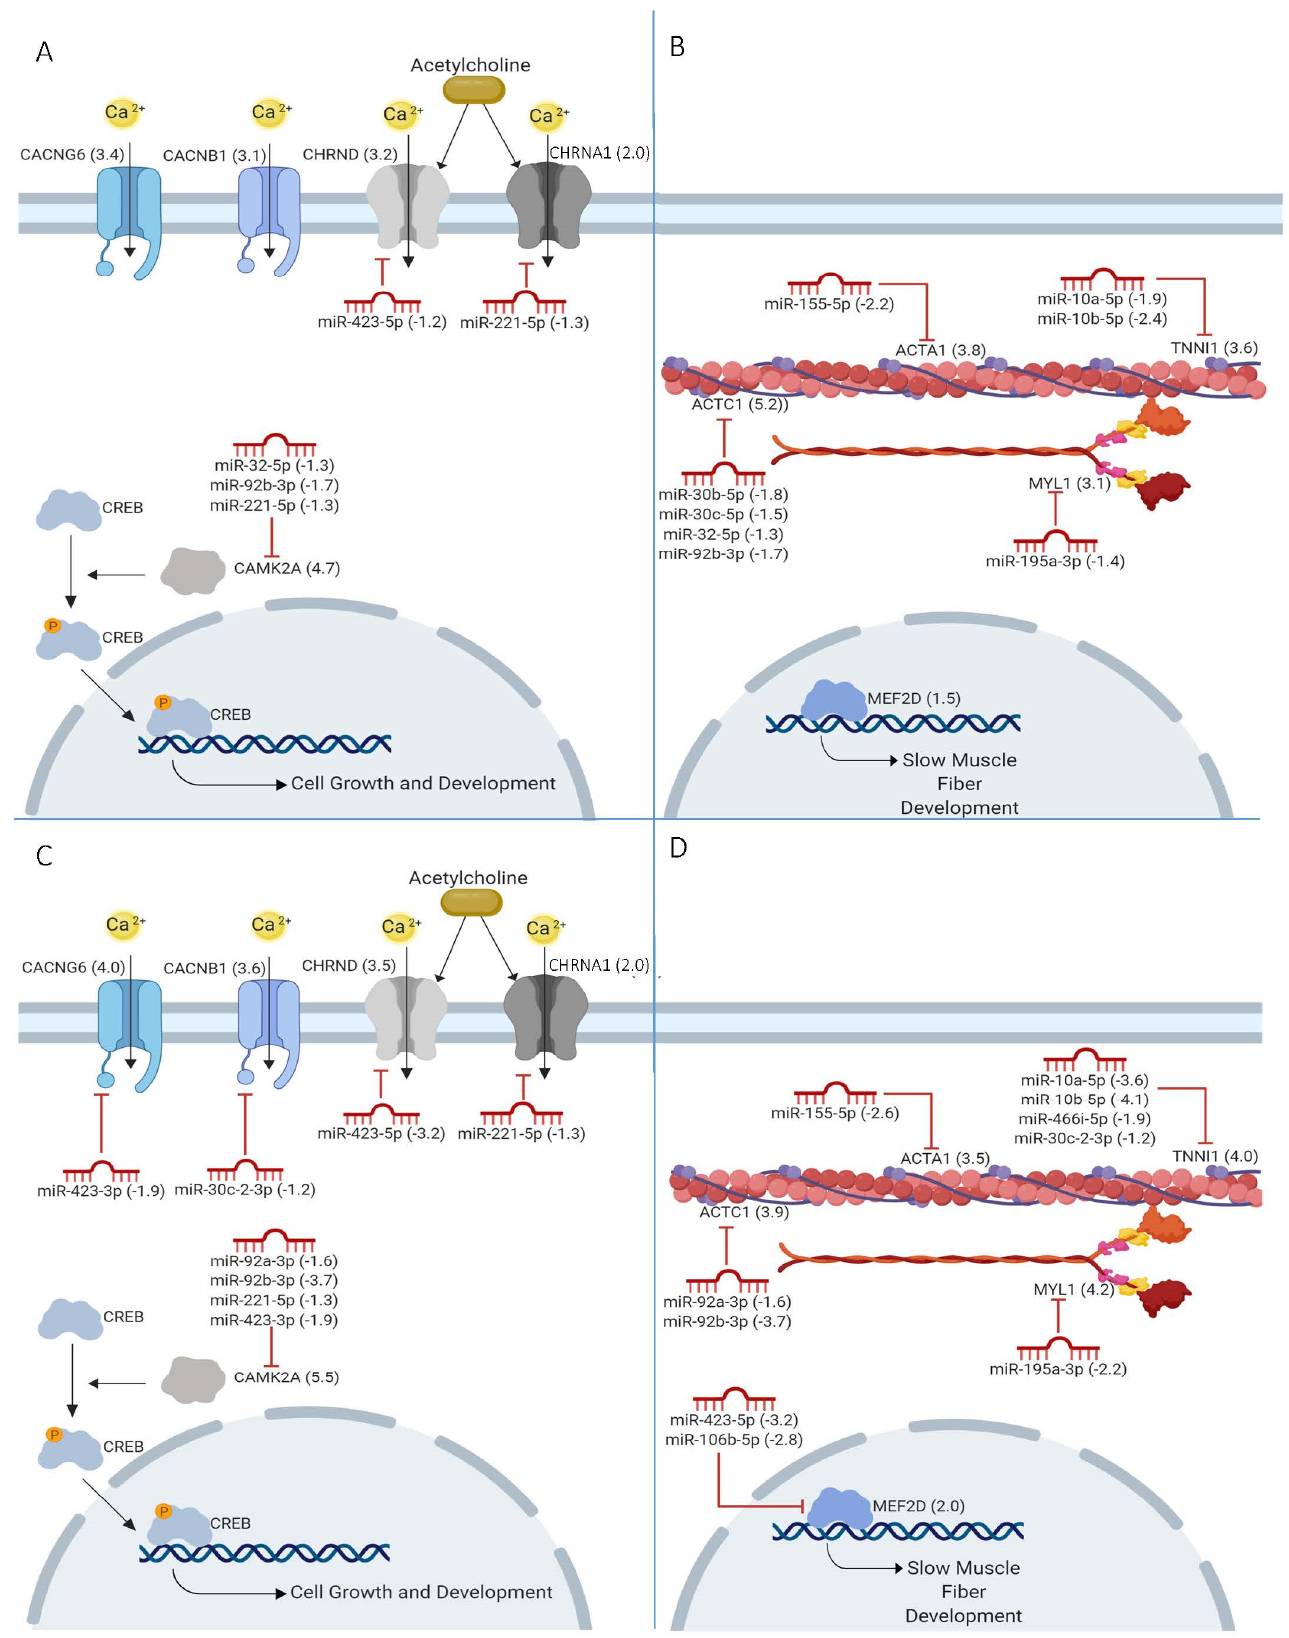
Figure 3. miRNAs are predicted to target multiple mRNAs at D2_D0 ( A , B ) and D5_D0 ( C , D ) that encode proteins related to calcium signaling ( A , C ) and sarcomeres ( B , D ).